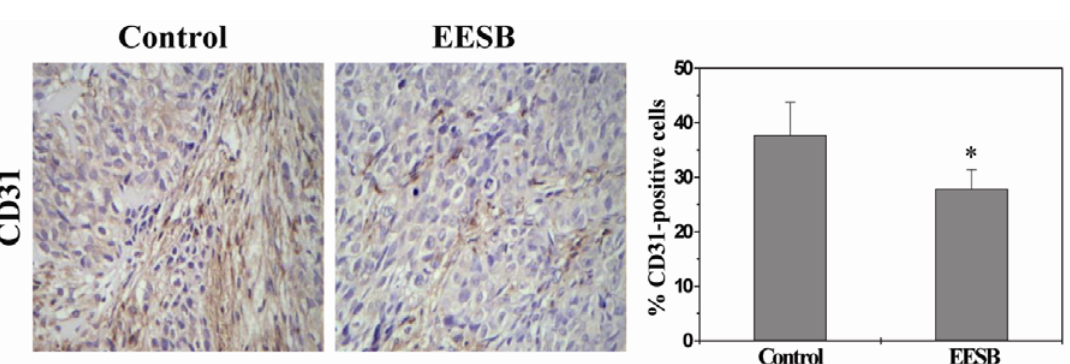
Figure 2. Effect of EESB on the intratumoral microvessel density in CRC xenograft mice. Tumor tissues were processed for immunohistochemical (IHC) staining for CD31. The photographs were representative images taken at a magnification of ×400. Quantification of IHC assay was represented as percentage of positively-stained cells. Data shown were averages with S.D. (error bars) from 10 individual mice in each group. * p < 0.05, versus